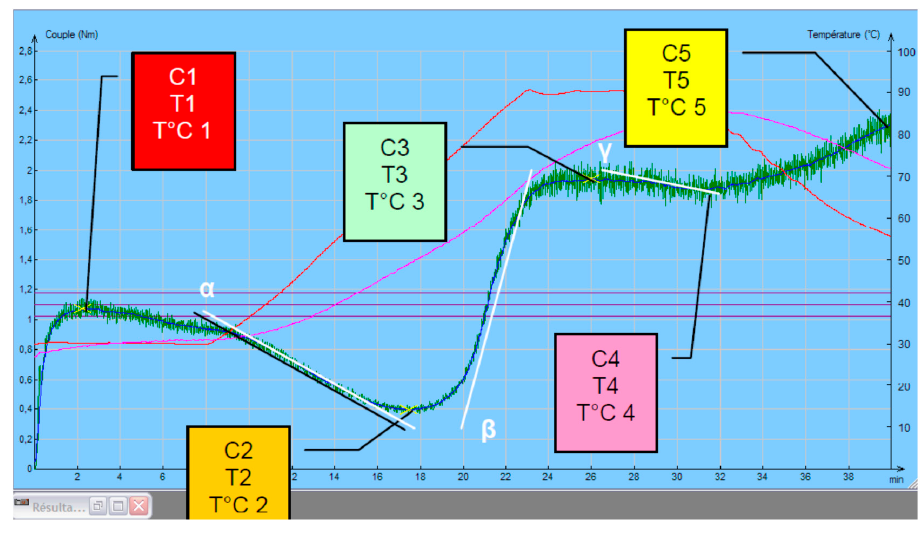
Figure 1. Mixolab parameters.